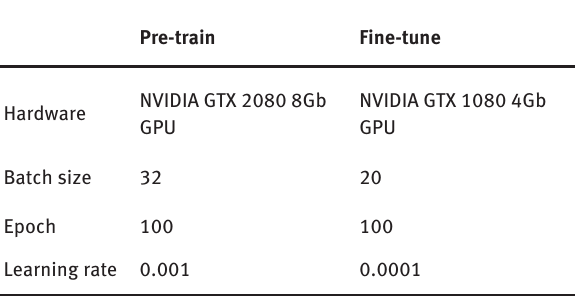
Table 1: Parameters during pre-training and fine-tuning